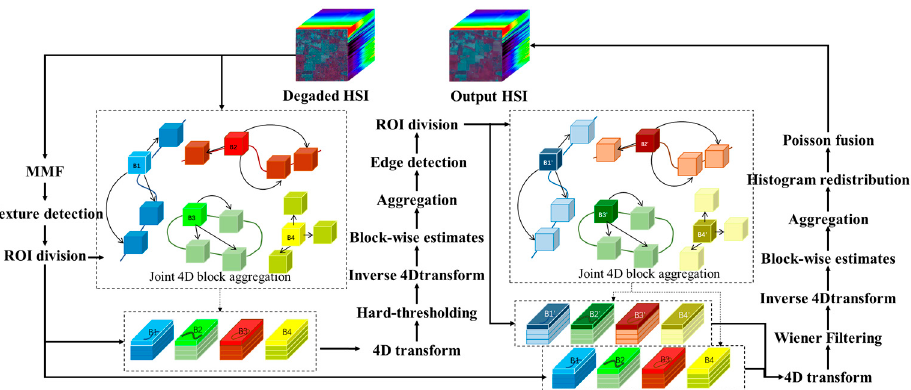
Figure 1. Process flow of the proposed algorithm. The function and process of each block are detailed in Section 2.